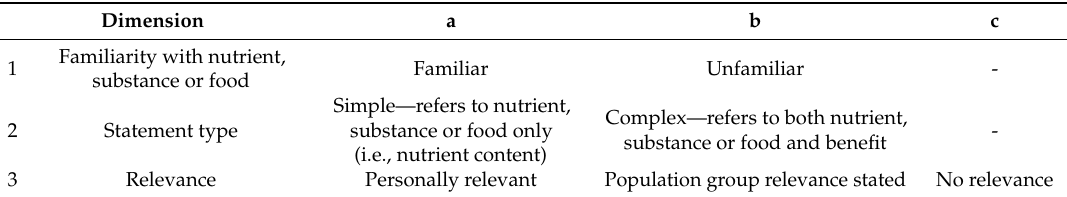
Table 5. Proposed typology dimensions for nutrition and health